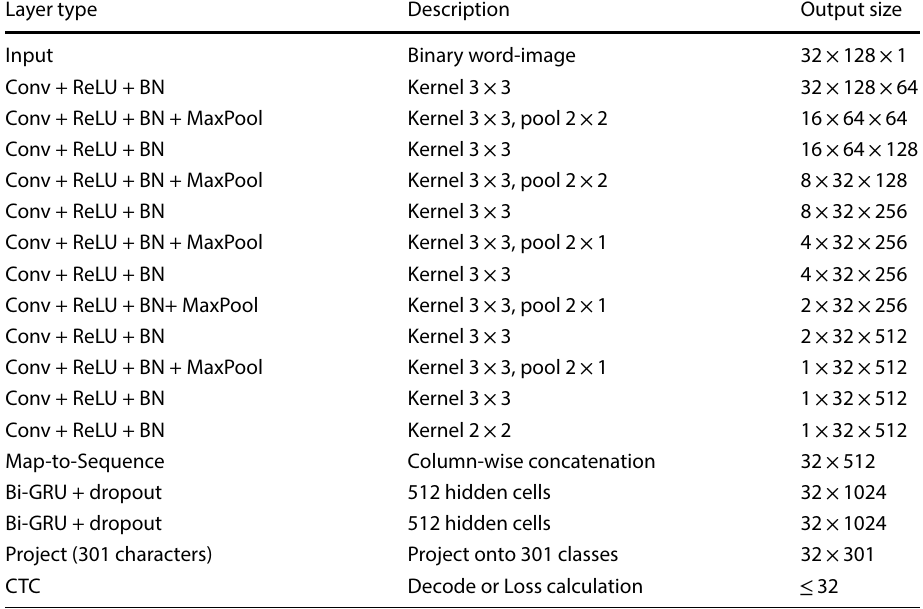
Table 1 Description of AHWR custom CNN model